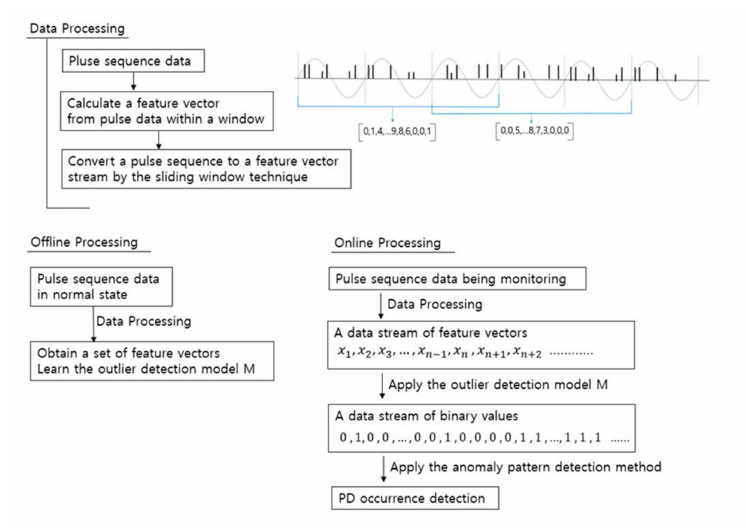
Figure 1. A flowchart of the proposed partial discharge (PD) detection method.